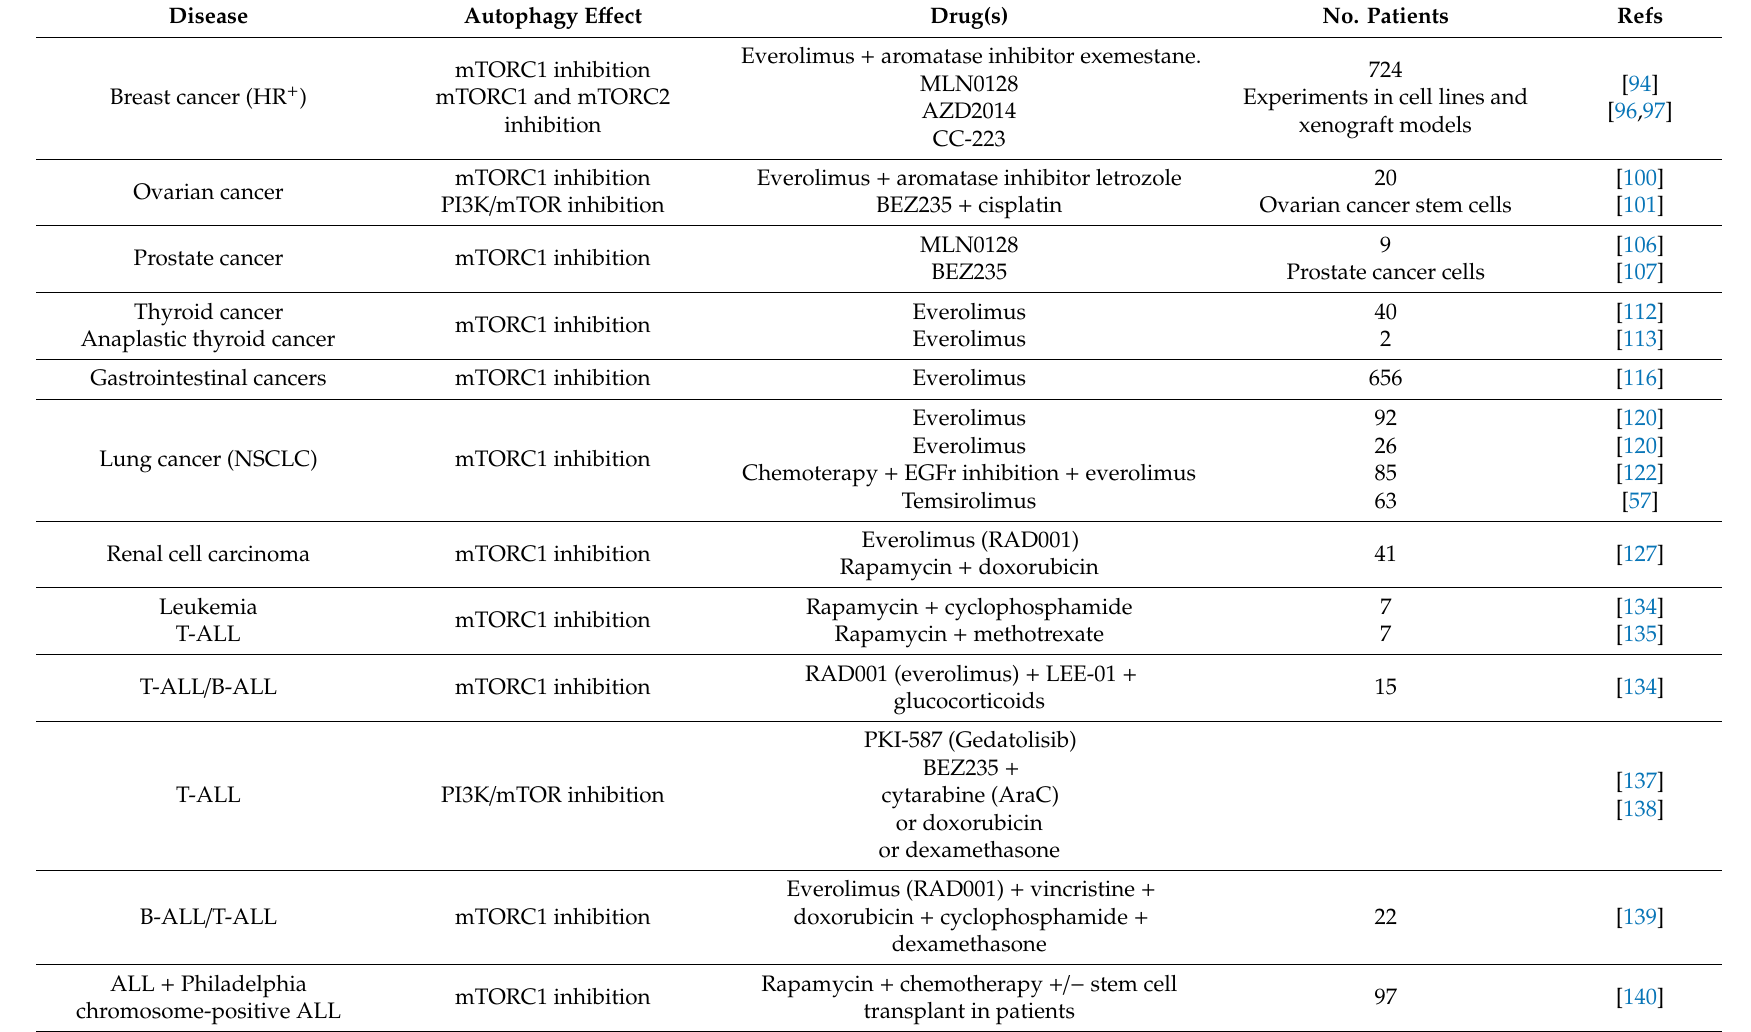
Table 4. mTOR inhibitors in clinical trials. B-ALL: B-cell ALL, NSCLC: non-small cell lung cancer, T-ALL: T-cell ALL.